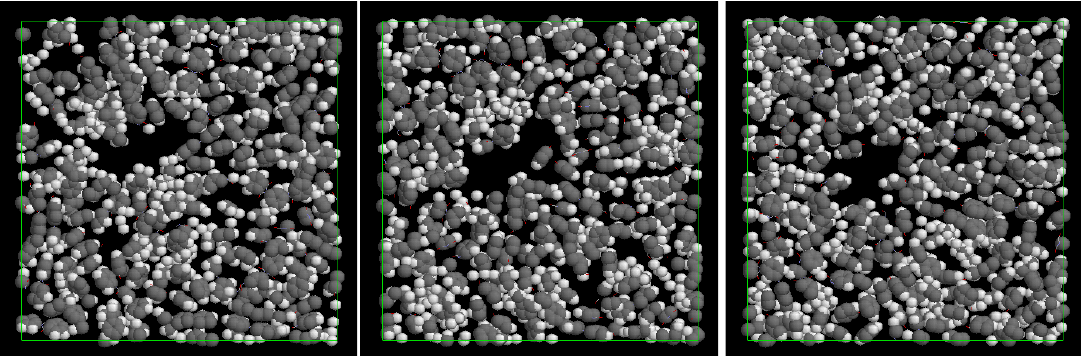
Figure 3. Visualization of free volume in Ultem, the density is 1.279 g/cm 3 . Successive slices in the range 0–10.5 Å.